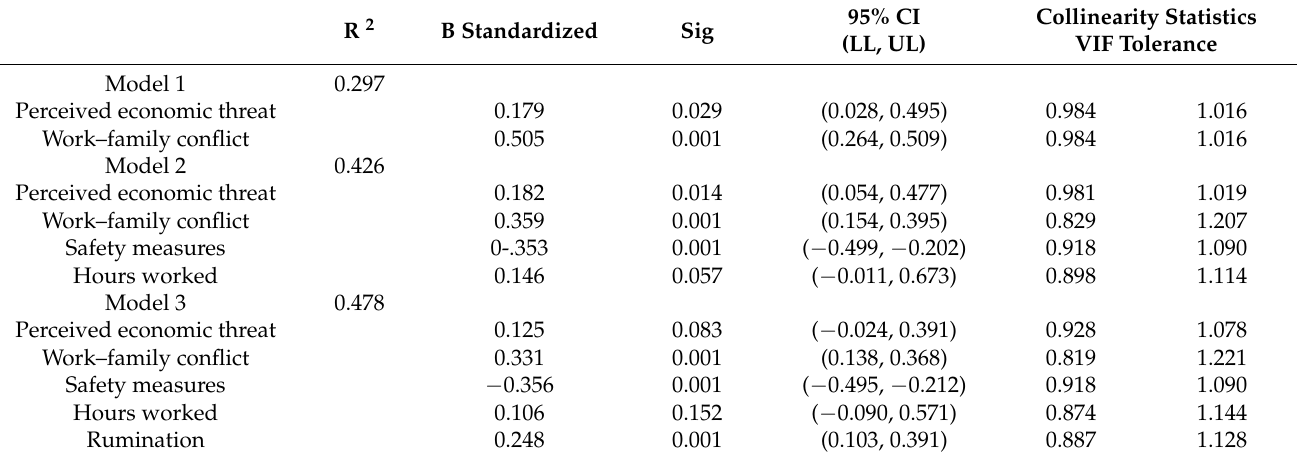
Among face-to-face workers, work–family conflict, security measures, and rumination explained the variance in work stress. In addition, perceived economic threat predicted job stress in a tendential manner (see Table 4). Table 4. Hierarchical regression on work-related stress among people with face-to-face jobs. R